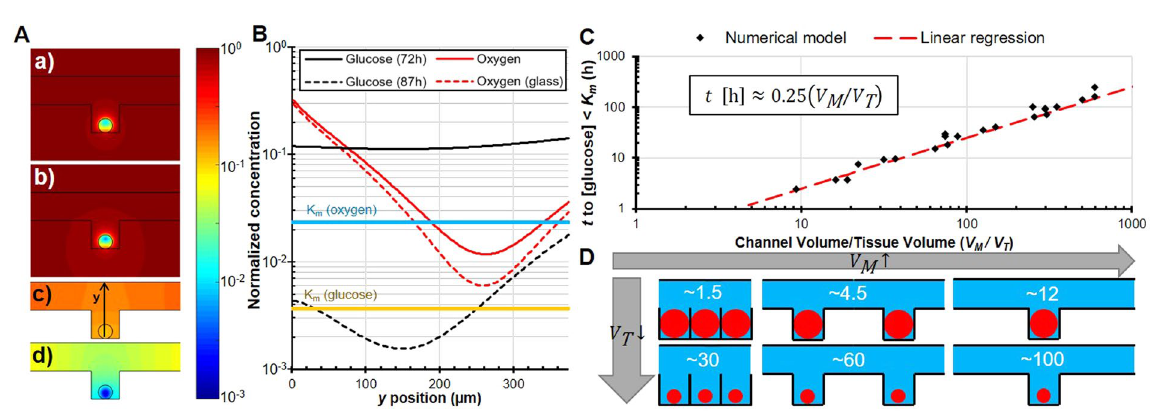
Figure 4. Spatial distribution of metabolites for V M / V T ≈ 300, d = 375 μ m and w = 750 μ m ( A ) Colour mapping of the distribution of (a) oxygen in a full PDMS device, (b) oxygen in a PDMS device set on a glass slide, (c) glucose after 3 days, and (d) glucose after 87 hours; all normalized by the saturation concentration. ( B ) Distribution of various nutrients through the tissue and their associated Michaelis-Menten constants. ( C ) Time in hours before the minimum concentration of glucose in the tissue dips under the Michaelis-Menten constant, indicating a possibility in affecting cell metabolism as a function of the ratio of available volume per well on tissue volume (result of ~4,000 simulations). ( D ) Schematic of different available medium volume per well ( V M ) on tissue volume ( V T )